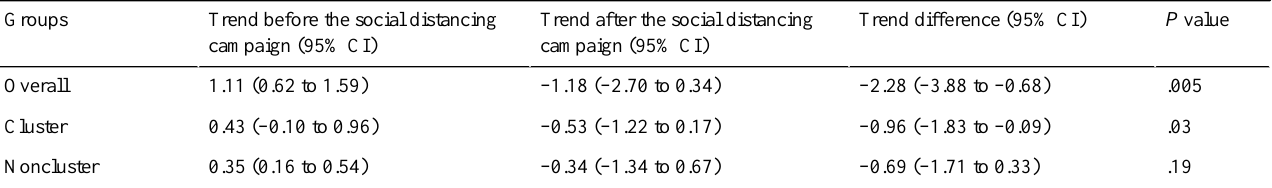
Table 3. New confirmed COVID-19 cases trends before and after a social distancing campaign in South Korea. a